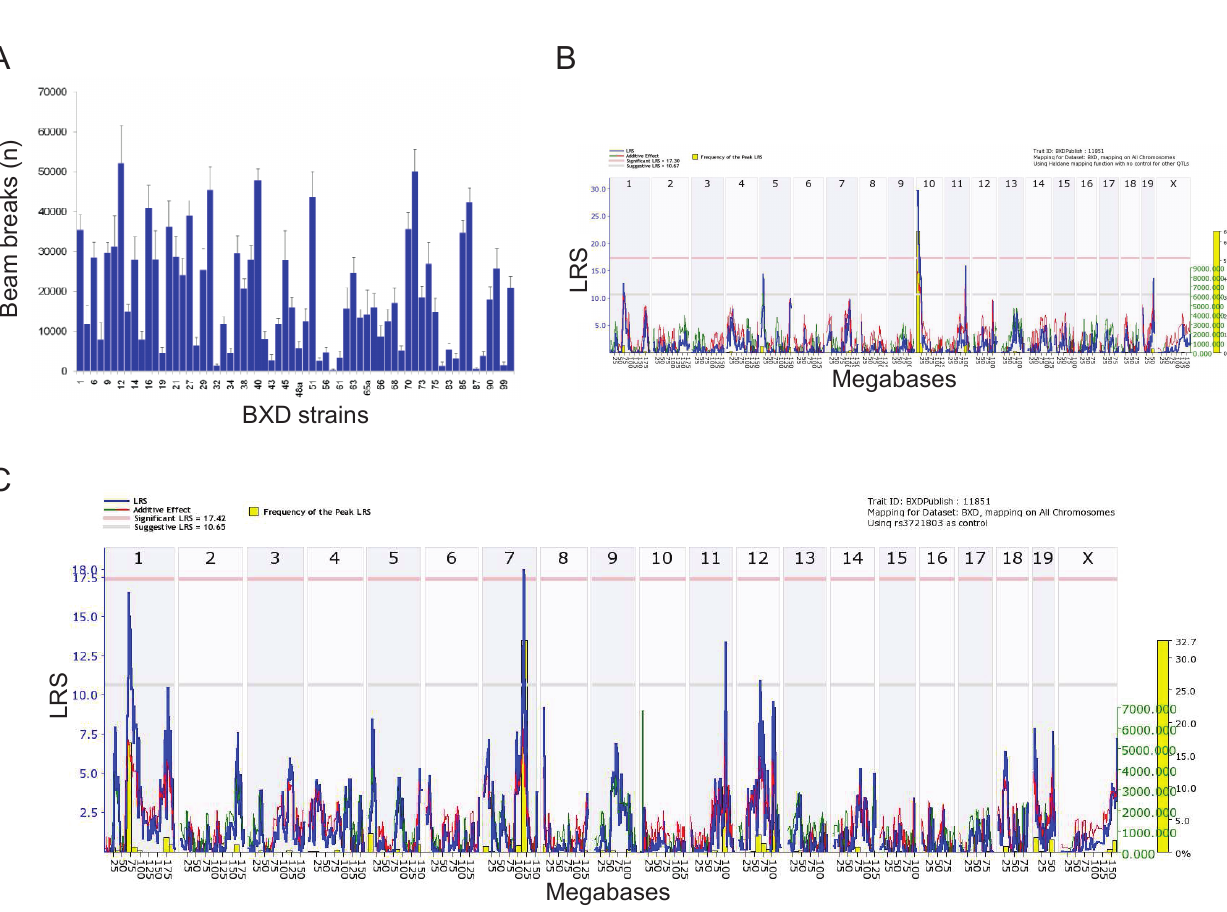
Figure 1. ( A ) Trait data for locomotion (number of beam breaks as a measure of distance traveled) for 64 BXD strains post morphine injection (Trait id 11851). ( B ) Whole genome scan showing a robust QTL on Chromosome 10 (Trait id 11851, SNP rs372180). The x-axis represents chromosome number and megabase position and the y-axis represents the likelihood ratio statistic (LRS) of linkage. Blue lines indicate LRS across the genome. The pink and gray horizontal lines are approximate threshold values which are used to assess whether a peak is significant (P<0.05) or suggestive (P<0.63), respectively. Red and green lines represent the additive genetic contribution: red lines indicate negative values (C57BL/6J alleles increasing trait values) and green lines indicate positive values (DBA/2J alleles increasing trait values). Gray lines are shown when the parental strain is unknown. The yellow bars represent the relative frequency of peak LRS at a given location from 2000 bootstrap resamples ( C ) Composite interval mapping of locomotion (Trait id 11851) after correcting for the peak on Chromosome 10 reveals a significant QTL on Chromosome